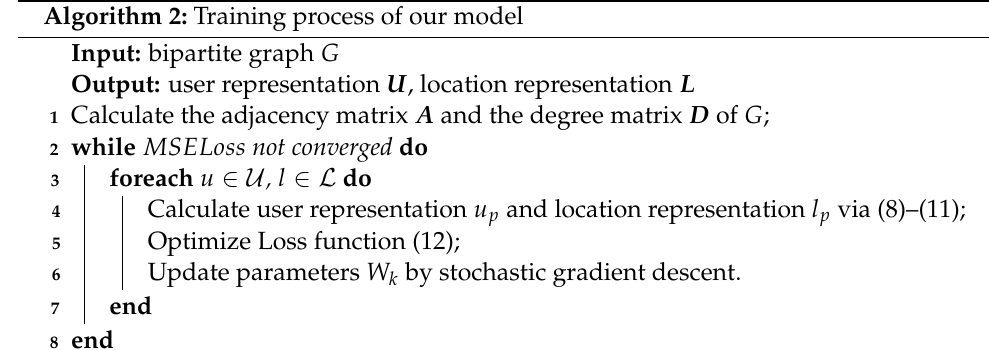
Algorithm 2: Training process of our